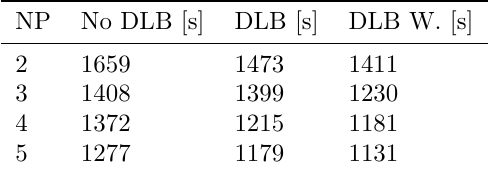
Table 1. Execution times comparing solutions with estimated processing weights (DLB W.), uniform pro- cessing weights (DLB) and without a load balancing (No DLB) framework (Intel i3 - 1 computing unit + Intel i7 - 4 computing units).